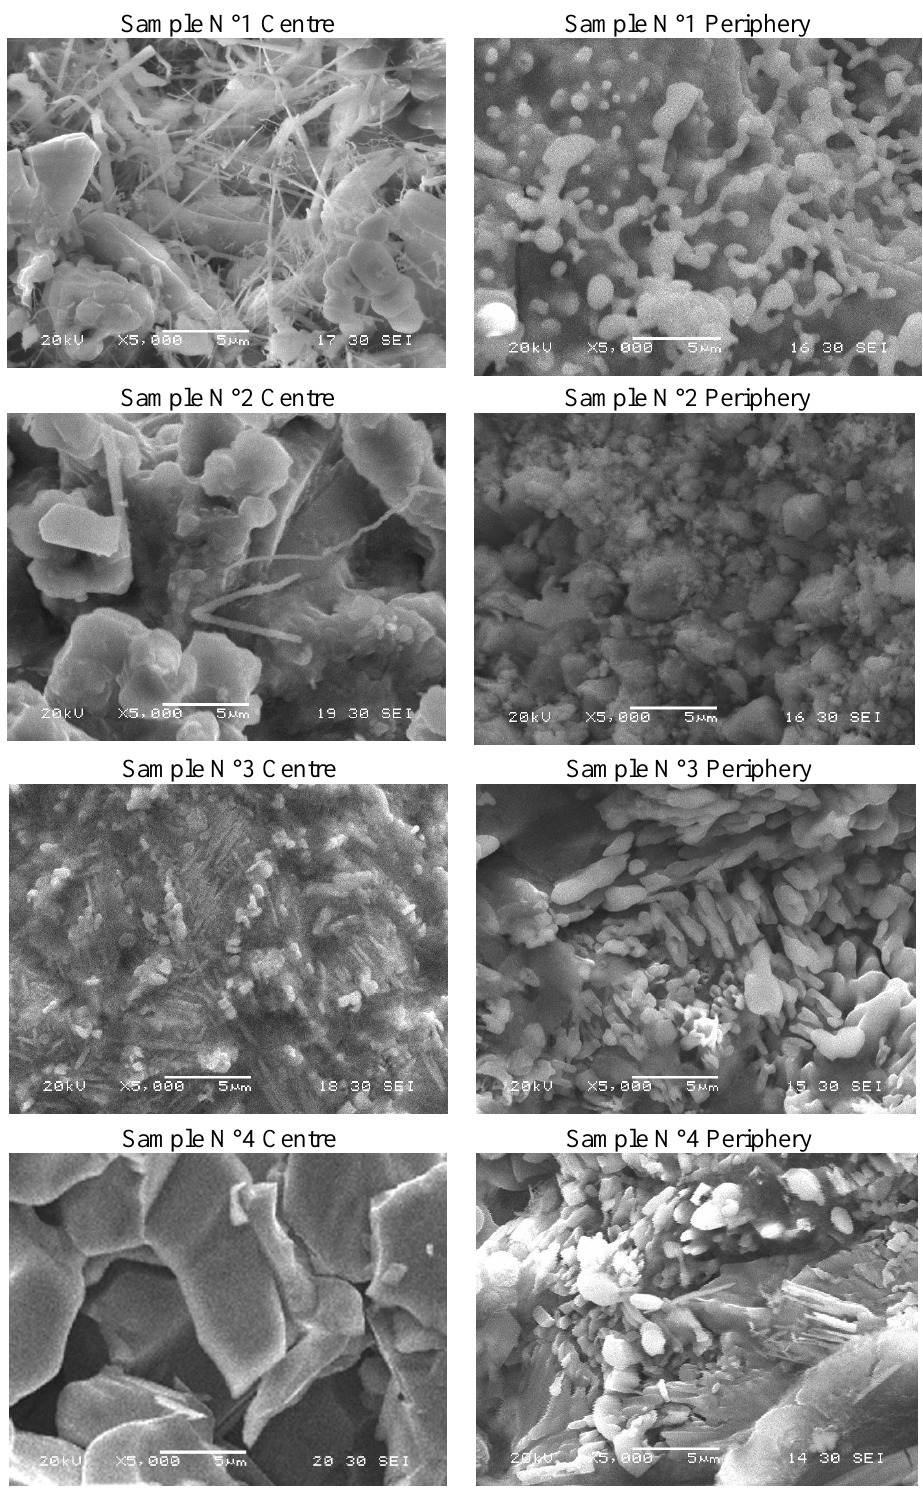
Figure 3. SEM microstructures of master alloys produced without